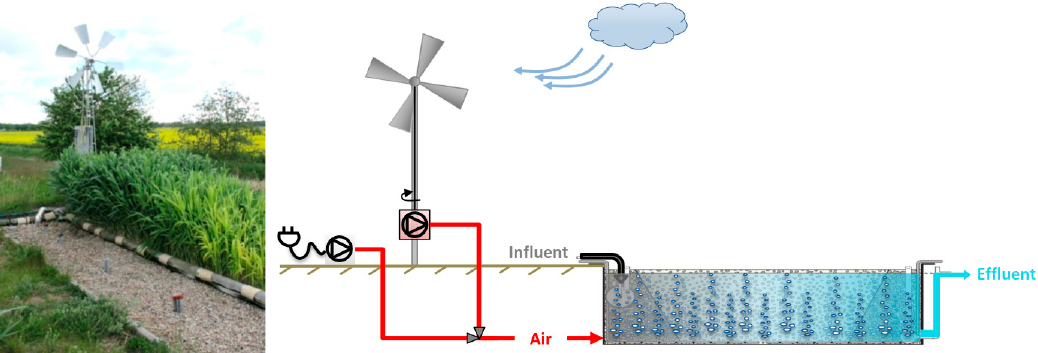
Figure 1. Pilot system at the Ecotechnology research facility in Langenreichenbach, Germany, including a photo of the wind power system and experimental treatment wetland ( left ), and a schematic of the experimental setup.